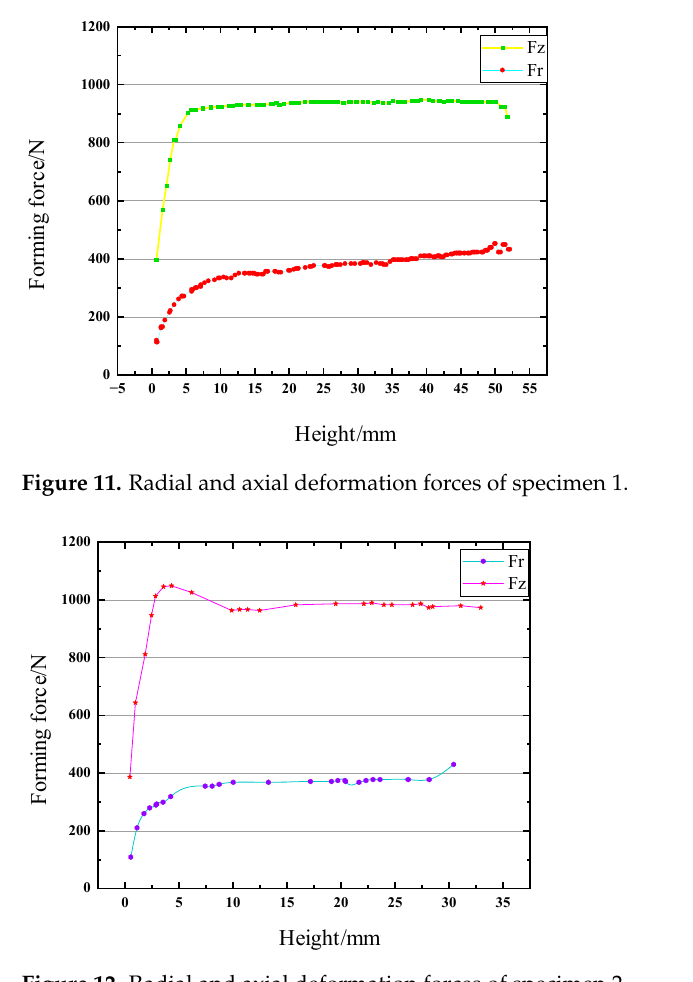
Figure 12. Radial and axial deformation forces of specimen 2.